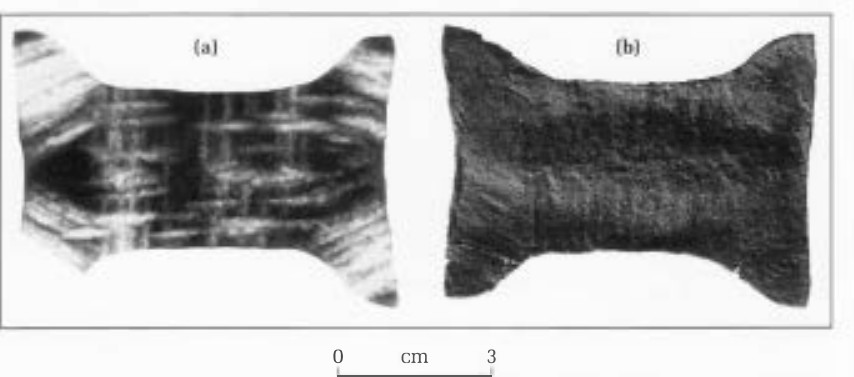
Figure 3 One naipe from Huaca Loro, Si can: {a) X-radiograph showing a complex pat­ tern of markings {such markings become more visible when naipes are cleaned or X-rayed); {b) the markings revealed by investigative conservation